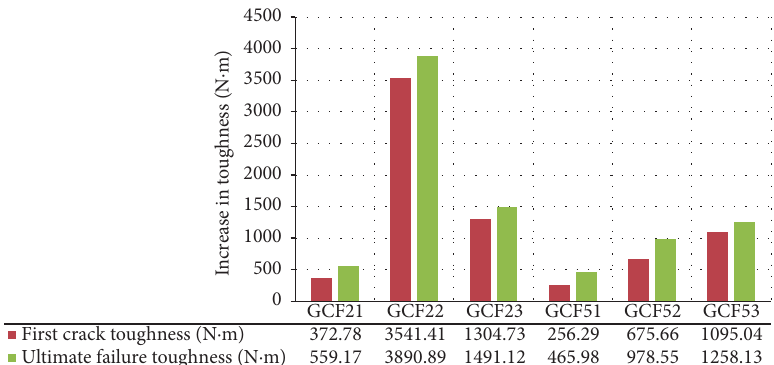
Figure 11: Increase in toughness of fibre reinforced geopolymer concrete to its reference concrete (GCF21, GCF22, and